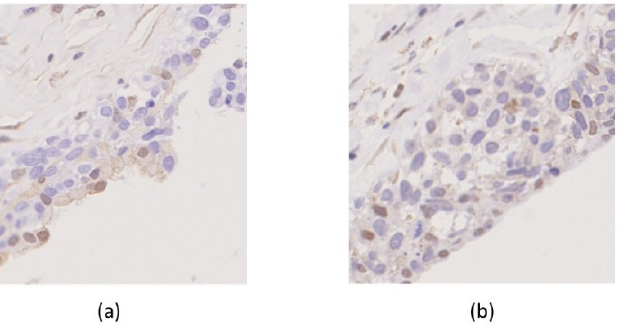
Figure 7. Immunohistochemical findings. The epithelium from mature cystic teratoma showed a mosaic pattern for PTEN ( a : 10×) and RB1 ( b : 10×).